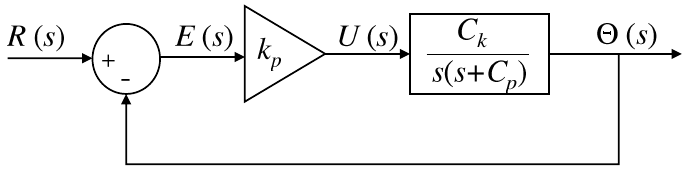
Figure 7. Closed loop DC motor proportional control block